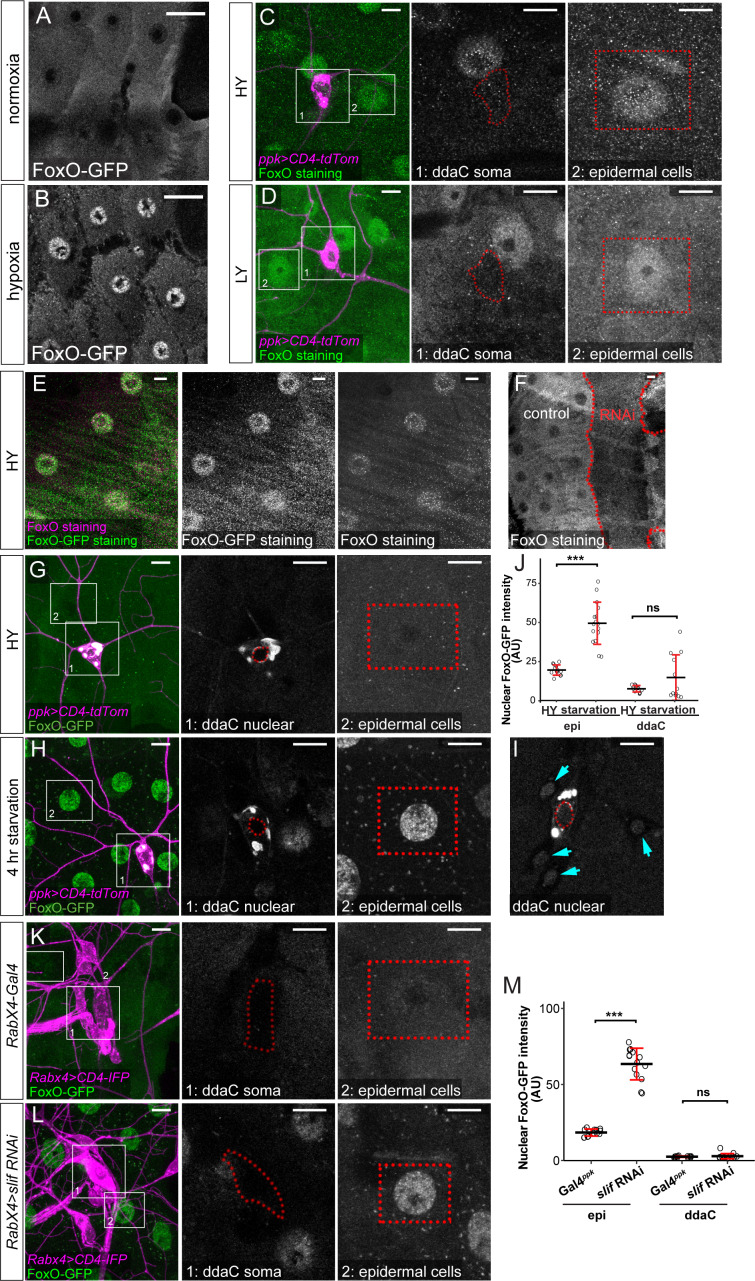
FoxO expression.(A and B) FoxO-GFP distribution in epidermal cells under normoxia (A) and hypoxia (B). (C and D) FoxO staining (green) in da neurons (magenta) and epidermal cells in HY and LY conditions in 2D projections. The insets for (C) and (D) show FoxO-GFP levels at ddaC somas (1) and epidermal cells (2) in single confocal sections. (E) FoxO and GFP staining in a foxo-GFP larva in HY. The nuclear localization of FoxO in (C–E) was likely caused by stress introduced during animal dissection. (F) FoxO staining in Gal4R16D01 > foxo RNAi animals. Gal4R16D01 domain is outlined by red dots. (G–H) FoxO-GFP (green) in C4da neurons (magenta) and epidermal cells in HY (G) and after 4 hr under starvation (H). The insets for (G) and (H) show FoxO-GFP levels at ddaC nuclei outlined by red dots (1) and epidermal cells (2) in single confocal sections. (I) FoxO-GFP in da neuron nuclei in another larva after 4 hr under starvation. The ddaC nucleus is outlined by red dots. The arrows point to nuclei of other da neurons. In (G–I), tdTom signals bled through the GFP channel in intracellular vesicles of ddaC neurons. (J) Quantification of nuclear FoxO-GFP levels in animals reared in HY and those subjected to starvation. Two-way ANOVA. The differences between HY and starvation in epi and ddaC are significantly different as indicated by a significant interaction term (p=0.000171). Each circle represents a segment; n = 13 for HY and n = 12 for starvation in both epi and ddaC. (K and L) FoxO-GFP (green) in da neurons (magenta) and epidermal cells in control (K) and slif RNAi (L) animals in HY condition in 2D projections. The insets for (K) and (L) show FoxO-GFP levels at ddaC somas (1) and epidermal cells (2) in single confocal sections. (M) Quantification of nuclear FoxO-GFP levels in control and slif RNAi animals in HY condition. Two-way ANOVA. The differences between control and slif RNAi in epi and ddaC are significantly different as indicated by a significant interaction term (p=2e-16). Each circle represents a segment; n = 13 for control and n = 15 for slif RNAi for both epi and ddaC. For both quantifications, ***p<0.001, ns, not significant. Black bars, mean; red bars, SD. Scale bars, 20 μm in (A) and (B), 10 μm in (C–I) and (K–L).